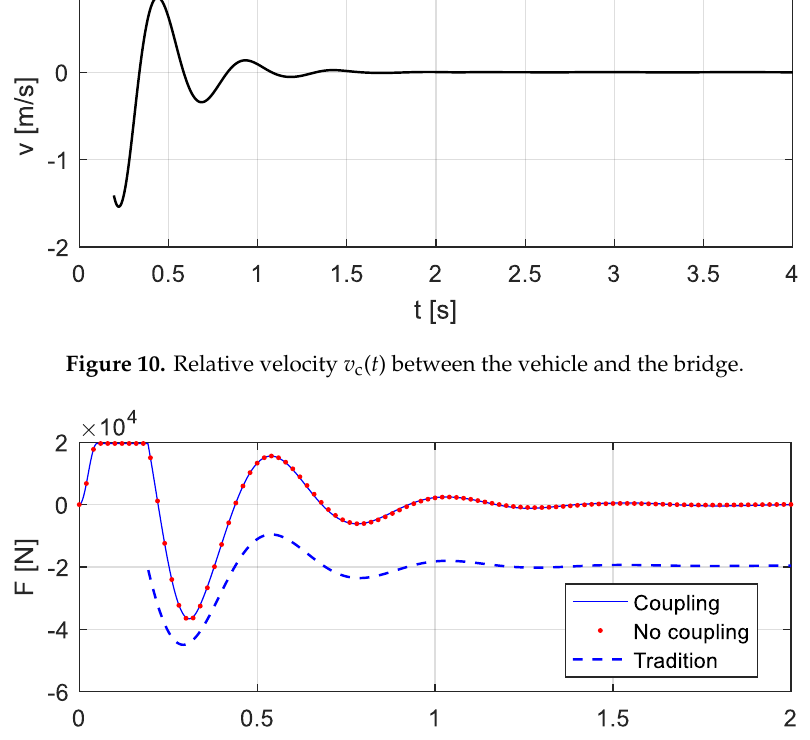
Figure 11. Comparison of the time history of vehicle bump-induced excitation considering different factors.